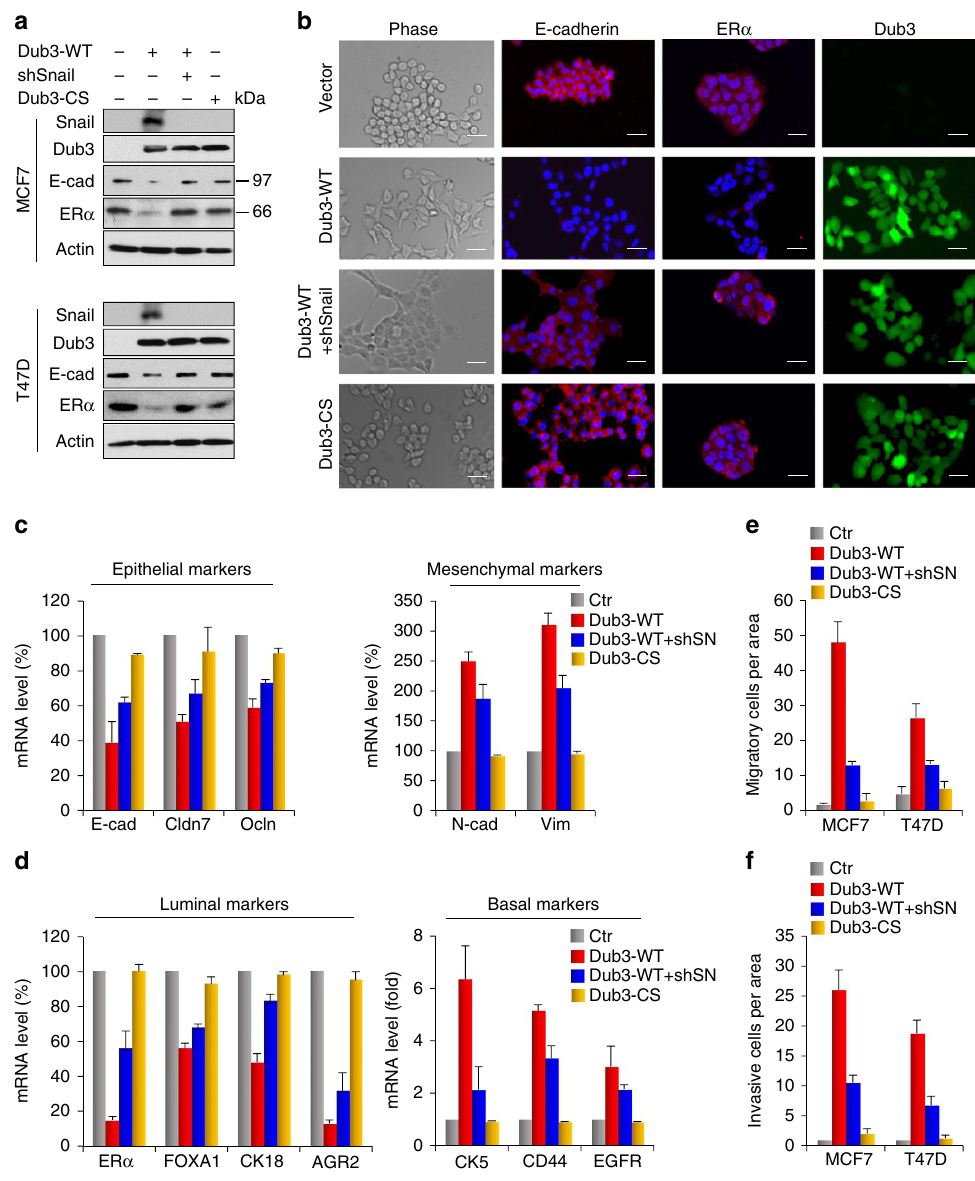
Figure 4 | Overexpression of Dub3 induces EMT. ( a ) WT- or CS-Dub3 was expressed in MCF7 and T47D cells. A rescue experiment with knockdown of Snail1 expression in WT-Dub3 expressing cells was also performed. The level of Snail1, Dub3, E-cadherin and ER a was analysed by western blot. ( b ) WT- or CS-Dub3 was expressed in MCF7 cells. A rescue experiment with knockdown of Snail1 expression in WT-Dub3 expressing cells was also performed. Morphologic changes indicative of EMT are shown in the phase contrast images; expression of E-cadherin, ER a and Dub3 was assessed by IF staining. Nuclei were visualized with DAPI (blue). Scale bars, 20 m m. ( c , d ) WT- or CS-Dub3 was expressed in MCF7 cells. A rescue experiment with knockdown of Snail1 expression in WT-Dub3 expressing cells was also performed. The mRNA levels of epithelial, mesenchymal ( c ), luminal, and basal ( d ) markers were quantitated by real-time PCR. Data are shown as mean ± s.d. of two separate experiments in triplicates. ( e ) Boyden chamber migration assay of modified MCF7 and T47D cells, as described in a . Data are presented as mean ± s.e.m. ( f ) Boyden chamber invasion assay of modified MCF7 and T47D cells, as described in a . Data are presented as mean ±